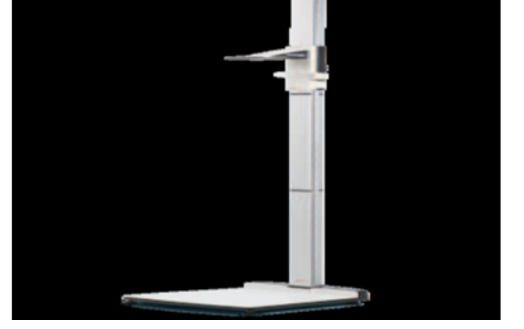
Figure 1. Standiometer. Figure 2. Digital Vernier caliper (600mm) .